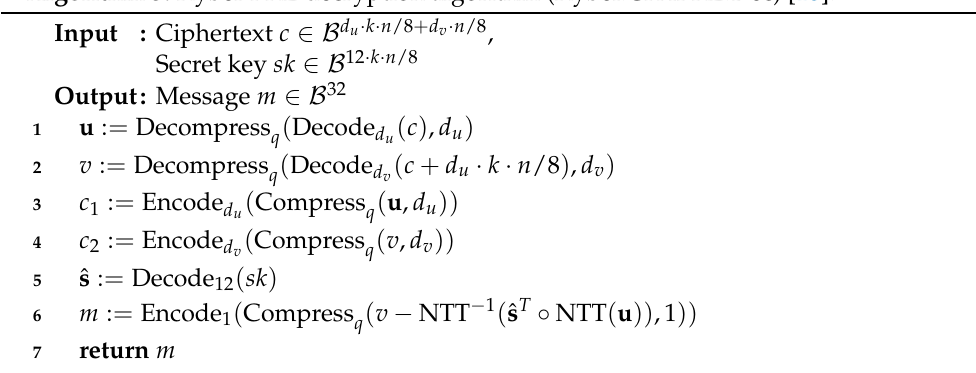
Algorithm 3: Kyber PKE decryption algorithm (Kyber.CPAPKE.Dec)